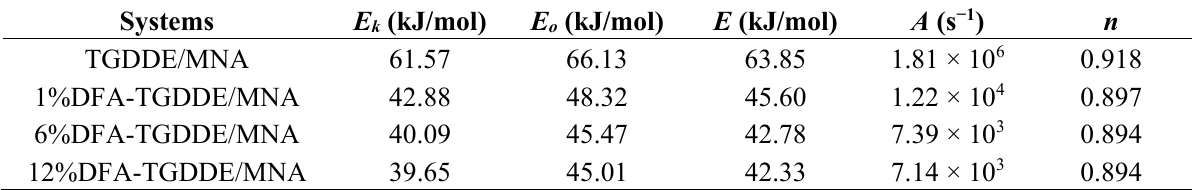
Table 2. The curing kinetic parameters of the curing